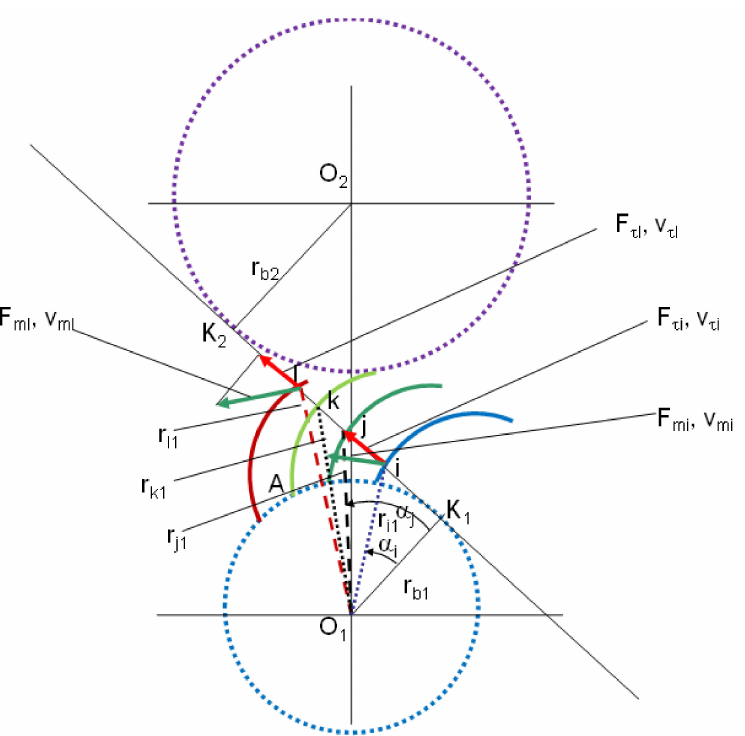
Figure 18. Distribution of forces and speeds in a cylindrical gear when there are several pairs of teeth engaged